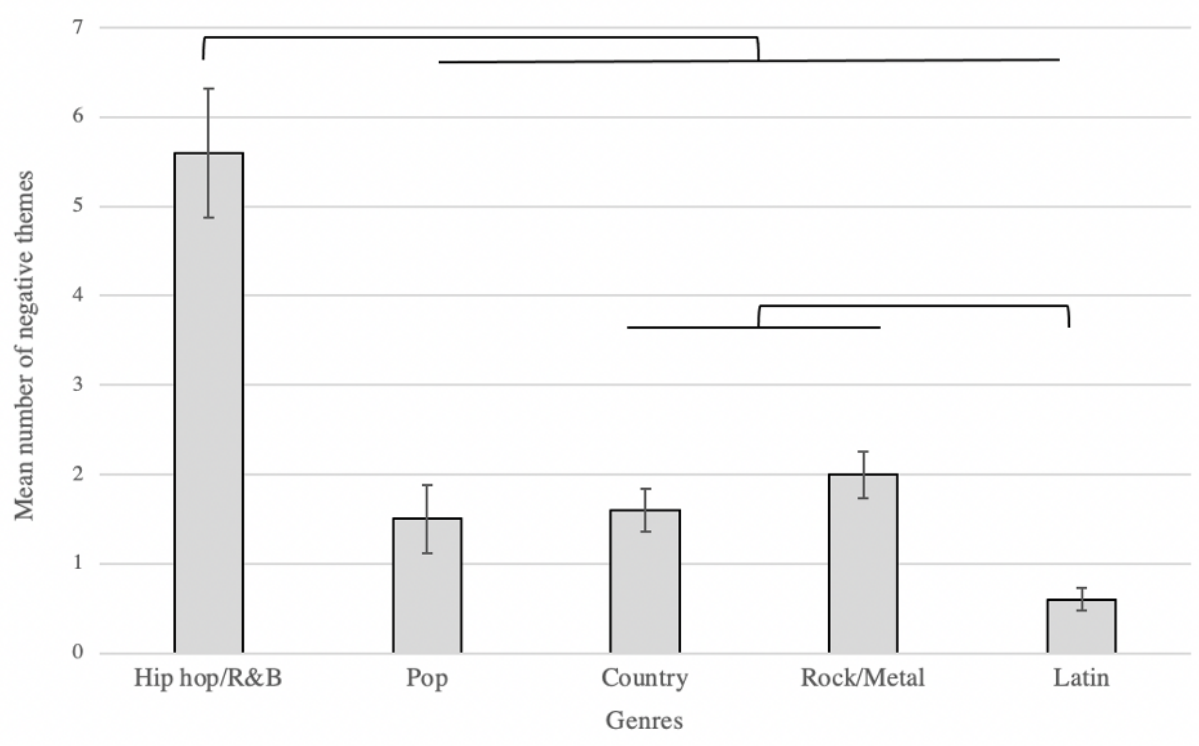
Figure 1. Mean number of negative themes in each genre from 1998 to 2018. Error bars reflect SE. Results show hip-hop/R&B had a significantly higher number of negative themes in lyrics when compared to other genres ( P <.001). Additionally, Latin music significantly differed from country ( P =.03) and rock/metal ( P <.001). R&B: rhythm and blues.